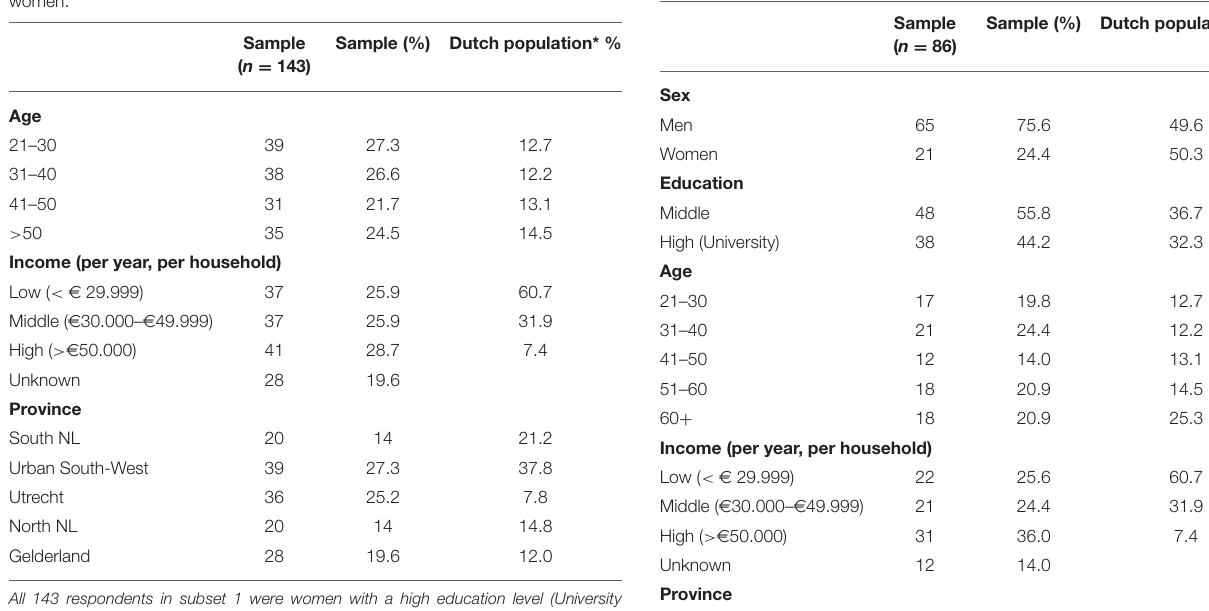
Table 2B | Socio-demographic characteristics of subset 2: